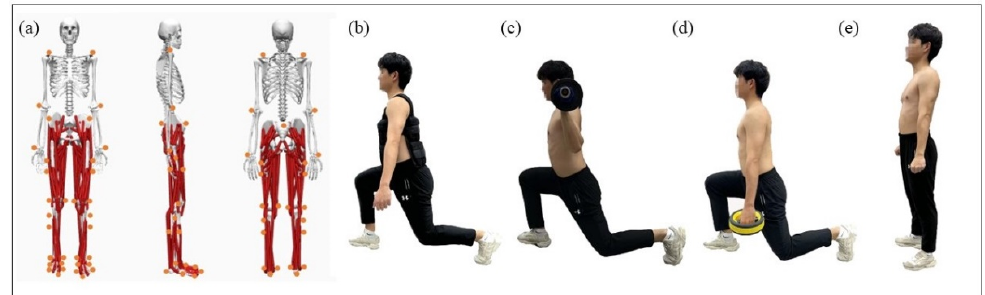
Figure 1. ( a ): Front, side, and back view of the subject’s reflective markers; ( b ): vest lunge pose; ( c ): barbell start pose; ( d ): dumbbell lunge pose; ( e ): lunge start pose.